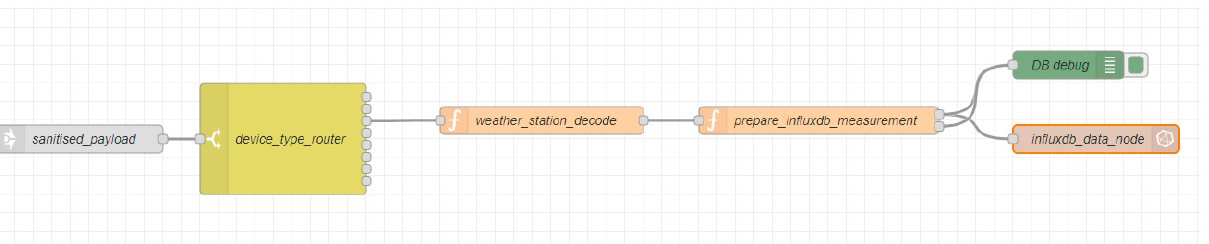
Figure 8. Node-RED flow—Data decoding of Netatmo weather station.